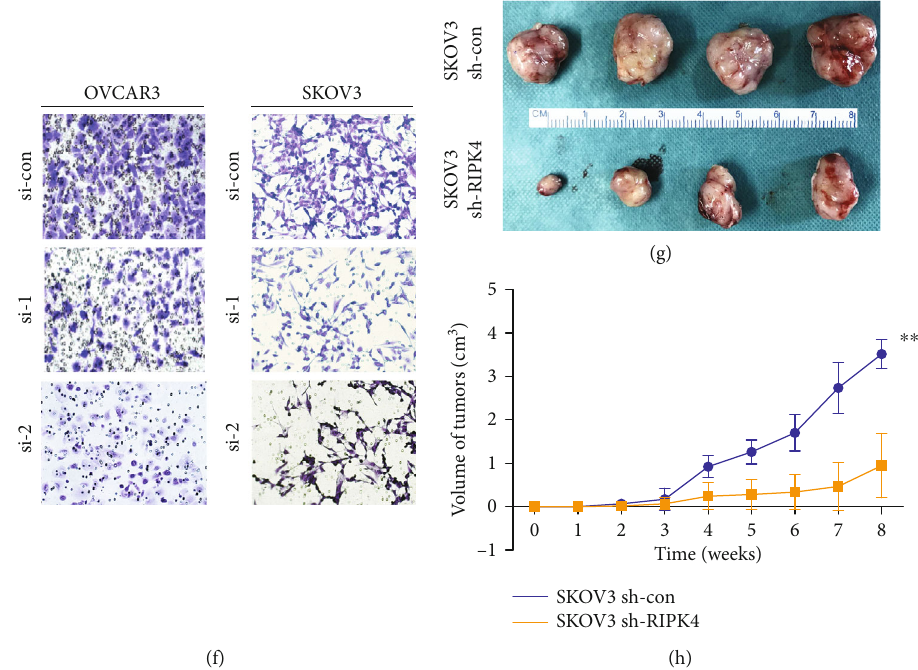
Figure 3: Silencing RIPK4 restrains OC cell migration and invasion. (a) RT-PCR was performed to assess the expression of RIPK4 in OC and normal ovarian cells. (b) RIPK4 silencing was carried out by using siRNA in SKOV3 and OVCAR3 cells. Silencing RIPK4 in OC cells signi fi cantly decreased their migratory ability, as observed in a wound healing assay (c and d), and their invasive ability, as observed in a Transwell assay (e and f). Images of subcutaneous xenografts are shown, n = 8 (g), and the tumour volumes of the SKOV3 subcutaneous xenografts in the RIPK4-silenced group and control group are shown (h). The data are shown as the mean ± SD , and statistical signi fi cance is indicated as follows: ∗∗ represents P < 0 : 01 and ∗ represents P < 0 : 05 (unpaired t